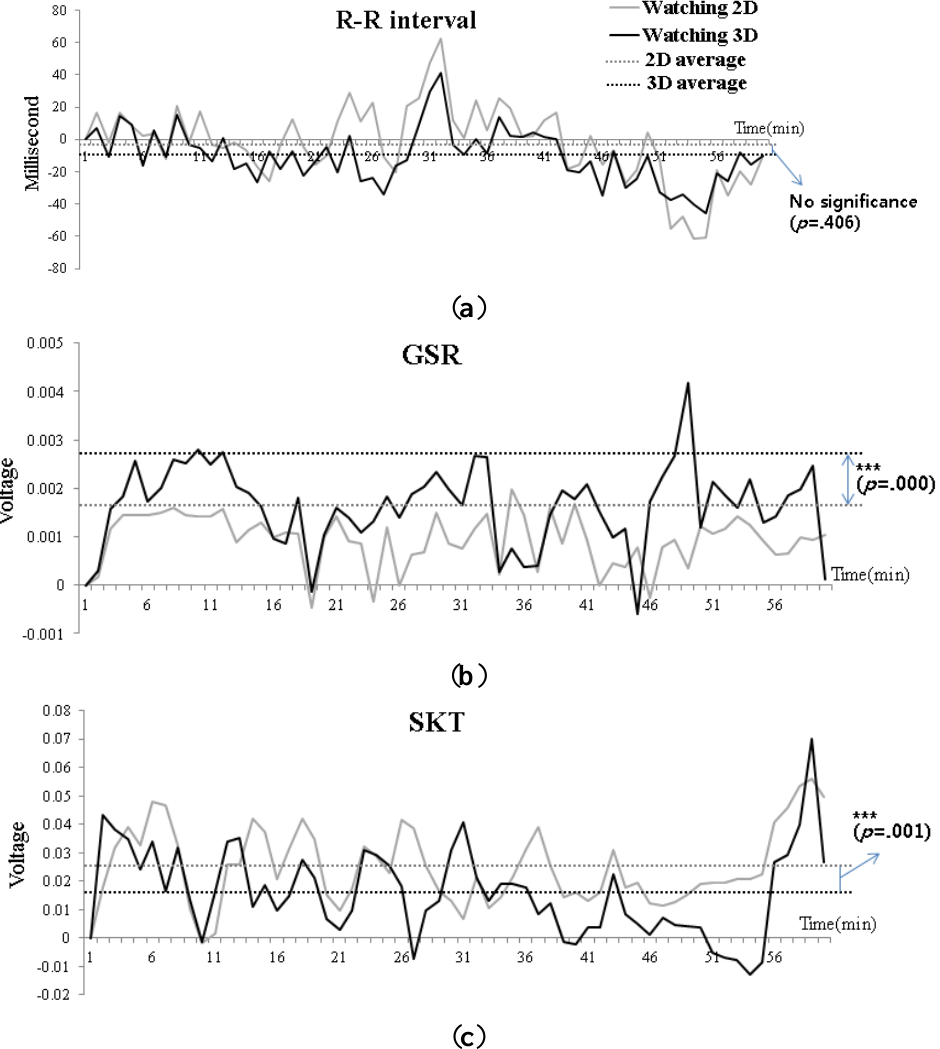
Figure 5. Temporal characteristics of autonomic nervous system responses in subjects viewing 2D or 3D displays (*** means statistically significant at confidence level of 99.9%). ( a ) R-R interval; ( b ) GSR; ( c ) SKT.